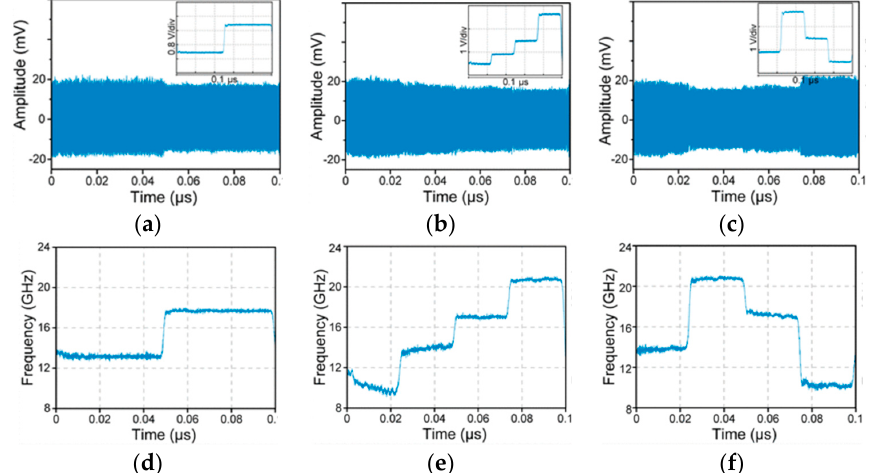
Figure 6. ( a )–( c ) Measured temporal waveforms of the frequency-hopping signal under different Figure 6. ( a – c ) Measured temporal waveforms of the frequency-hopping signal under di ff erent injection injection conditions. (Insets) Corresponding hopping code sequence S(t). ( d )–( f ) Recovered conditions. (Insets) Corresponding hopping code sequence S(t). ( d – f ) Recovered instantaneous frequency corresponding to ( a – c ), respectively (with the courtesy of Dr S.